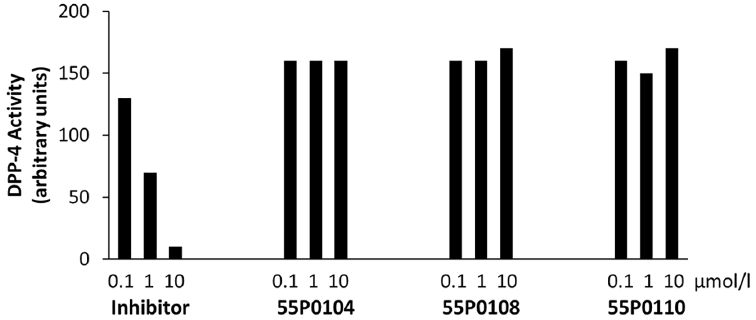
Fig 7. No direct effect of novel compounds on DPP-4 activity in vitro. Direct effects of 0.1, 1, or 10 μ mol/l 55P0104, 55P0108, 55P0110, or an established DPP-4 inhibitor as provided by the assay manufacturer on DPP-4 activity in vitro. Substrate conversion measured at least in duplicate at 5 min intervals over 60